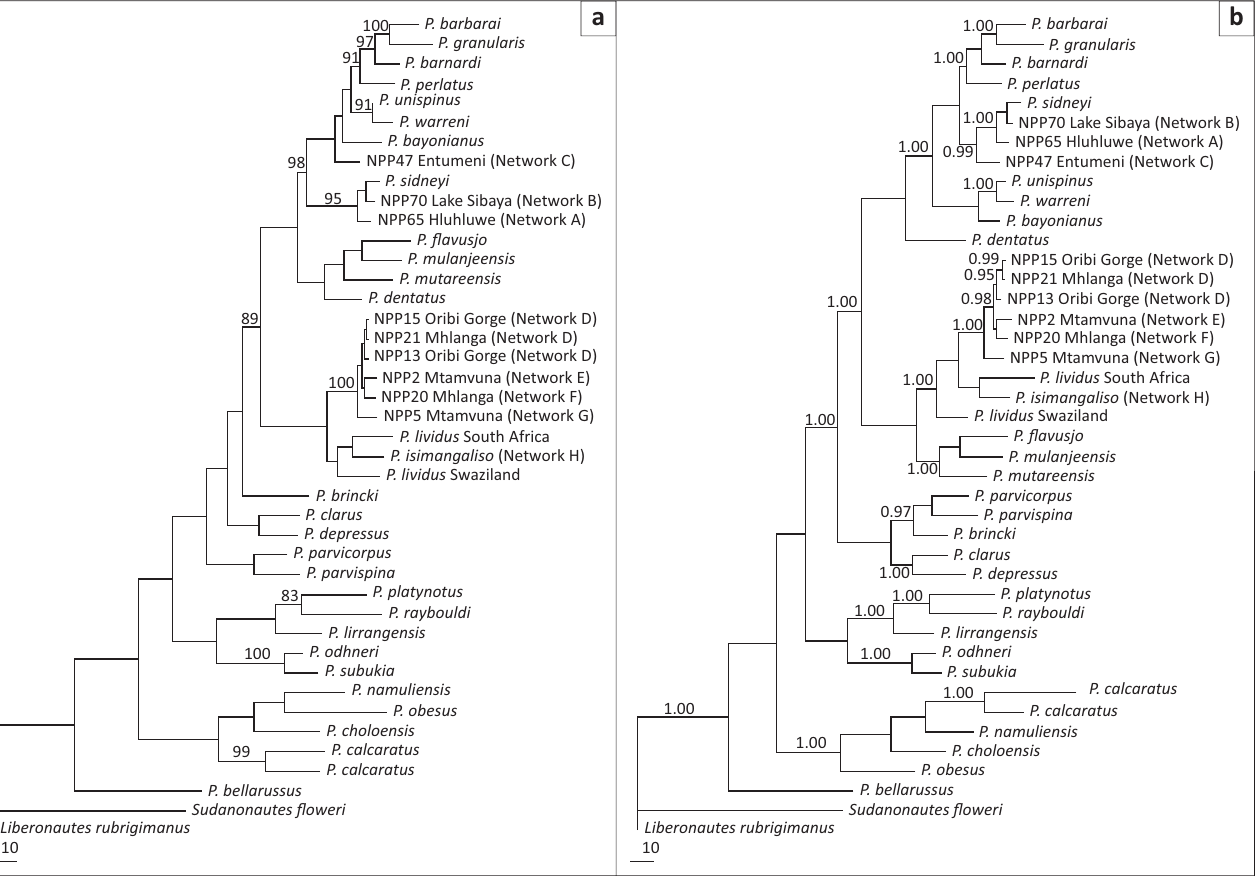
FIGURE 3: The phylogenetic placement, based on the parsimony and Bayesian analyses of combined cytochrome c oxidase subunit I and 16S ribosomal DNA sequence data partitions, of unique KwaZulu-Natal Potamonautes sidneyi lineages and Potamonautes isimangaliso , relative to Southern and Eastern African Potamonautes species: (a) the single most parsimonious tree (1106 steps, consistency index = 0.326, retention index = 0.543, rescaled consistency index = 0.177) and (b) the most likely (-lnL = 7841.114) topology obtained across the four Bayesian analyses. Numbers on the branches indicate bootstrap support (only values > 75 % are shown) and Bayesian Posterior Probabilities (only Bayesian Posterior Probabilities ≥ 0.95) for relationships in A and B,